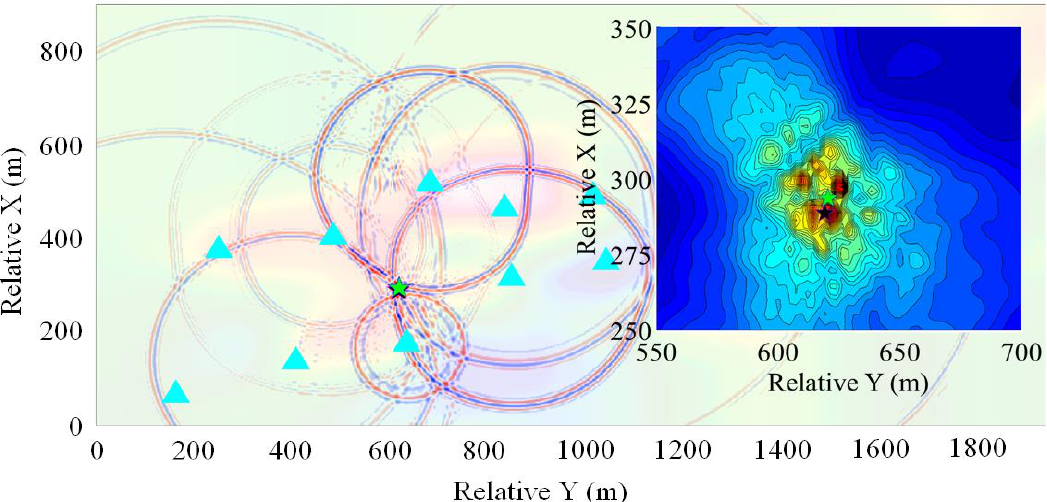
Figure 10. Location results of the GBRTM location method based on the windowed recording waveforms of the blasting event 3. The right panel shows the enlarged map of the stacking amplitude imaging near the true source location. The remaining legends are the same as those in Figure 9.